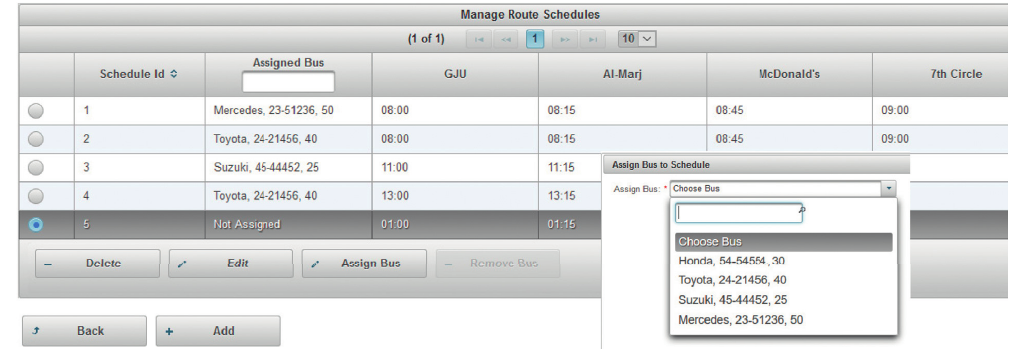
Figure 7: The manage route schedule screen in the admin